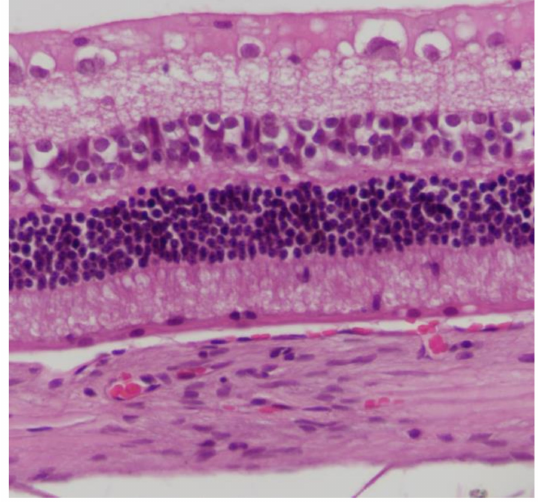
Figure 1. Group C. No pathological changes were observed on retina. EH × 200.